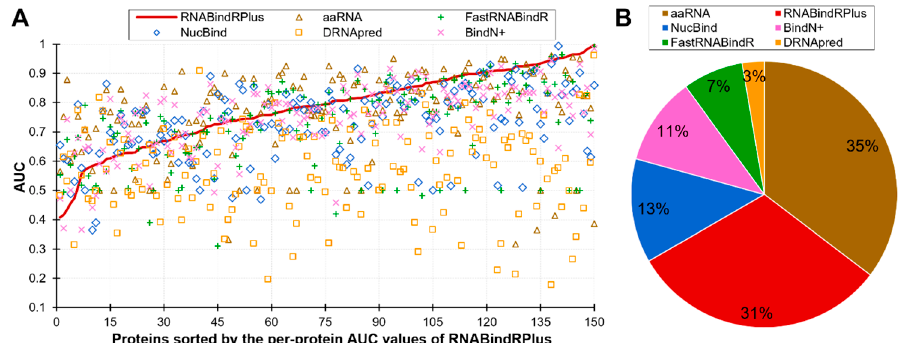
Figure 3. Complementarity of the six partner-agnostic sequence-based predictors of RBRs. This analysis focuses on the RNA-binding proteins as the calculation of the per-protein AUC is not possible for the other proteins. Panel ( A ) shows the per-proteins AUC values for proteins sorted by the AUCs of the best performing RNABindRPlus that are represented by the red line. Panel ( B ) shows the fractions of the RNA-binding proteins for which a given predictor secures the highest value of AUC. Predictors are sorted in descending order by the value of the fraction.